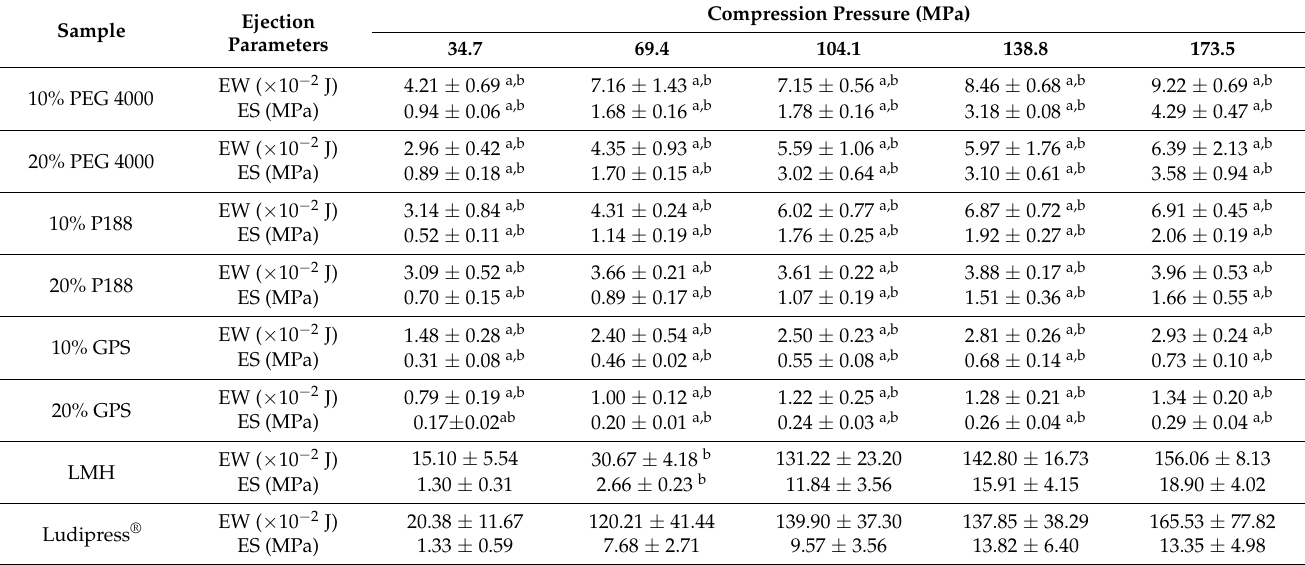
Table 4. Ejection parameters for co-processed mixtures, LMH and Ludipress ®